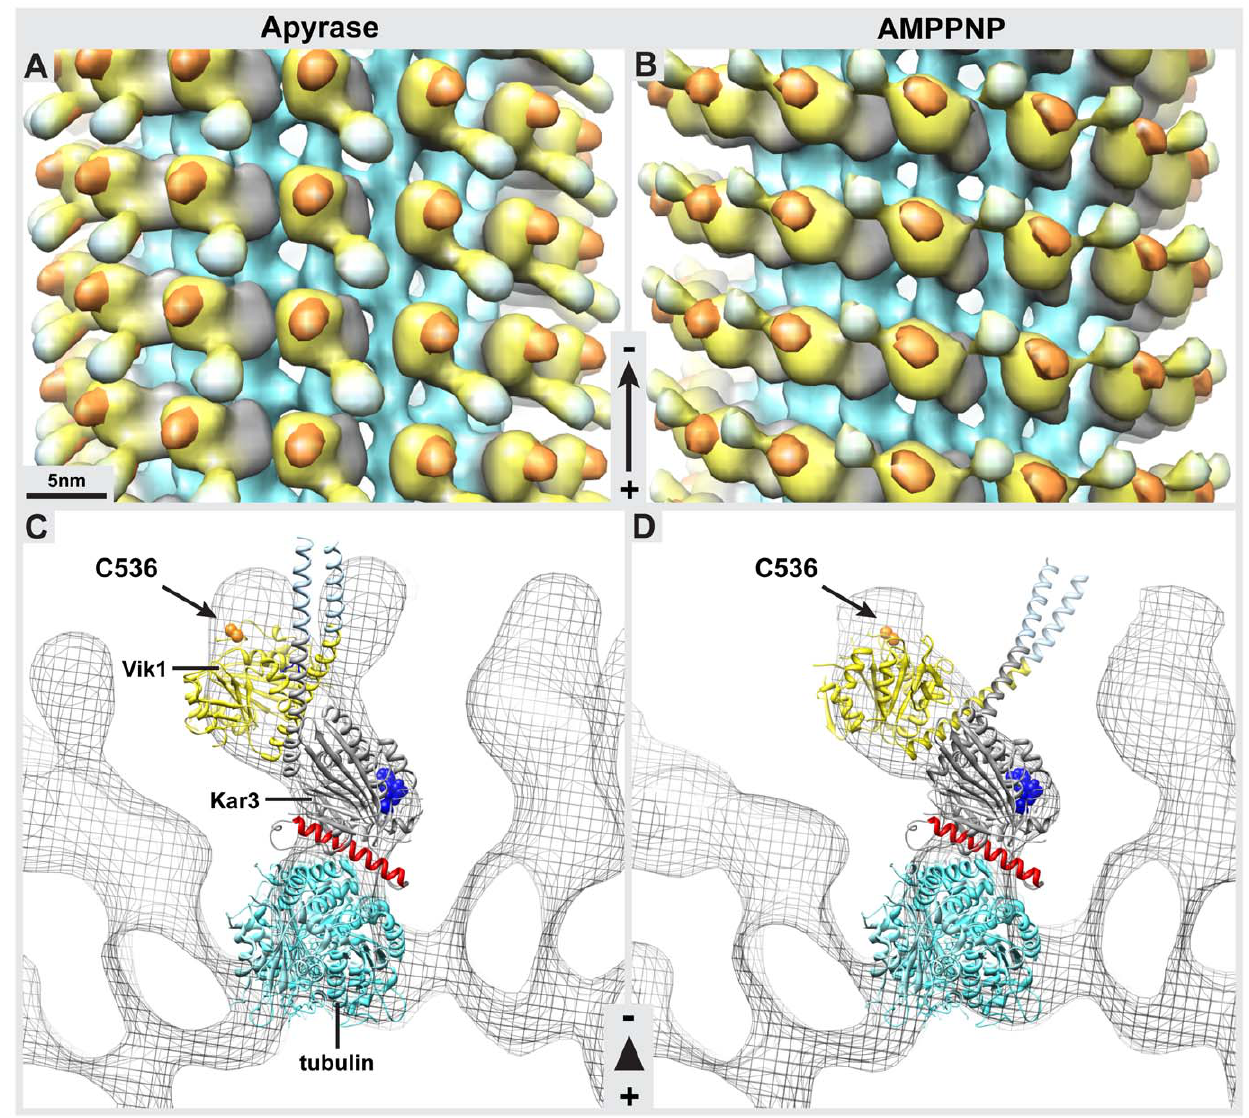
Figure 5. Nanogold H -labeling shows Kar3 is in contact with the MT in the nucleotide-free and AMPPNP states. Longitudinal views of helical averages of Nanogold H -labeled GCN4-Kar3CFVik1C536C in the nucleotide free ( A ) and AMPPNP ( B ) states. The density corresponding to the gold label is colored orange. ( C & D ) The X-ray crystal structures of tubulin (PDB accession: 1JFF; [33]) and Kar3Vik1 (PDB accession: 4ETP; [6]) docked into the scaffolds of Nanogold H -labeled GCN4-Kar3CFVik1C536C helical averages in the nucleotide-free ( C ) and AMPPNP states ( D ). Vik1 C536, the residue that was labeled with Nanogold H is colored in orange showing close agreement with the location of the Nanogold H in the helical reconstructions. The ADP molecule bound in the Kar3 active site on the crystal structure is shown in blue and helix a 4 of Kar3 is shown in red. Color key: tubulin - turquoise, Kar3 - gray, Vik1 - yellow, GCN4 coiled-coil (isosurface) or SHD coiled-coil (crystal structure) - pale blue, Nanogold H - orange.